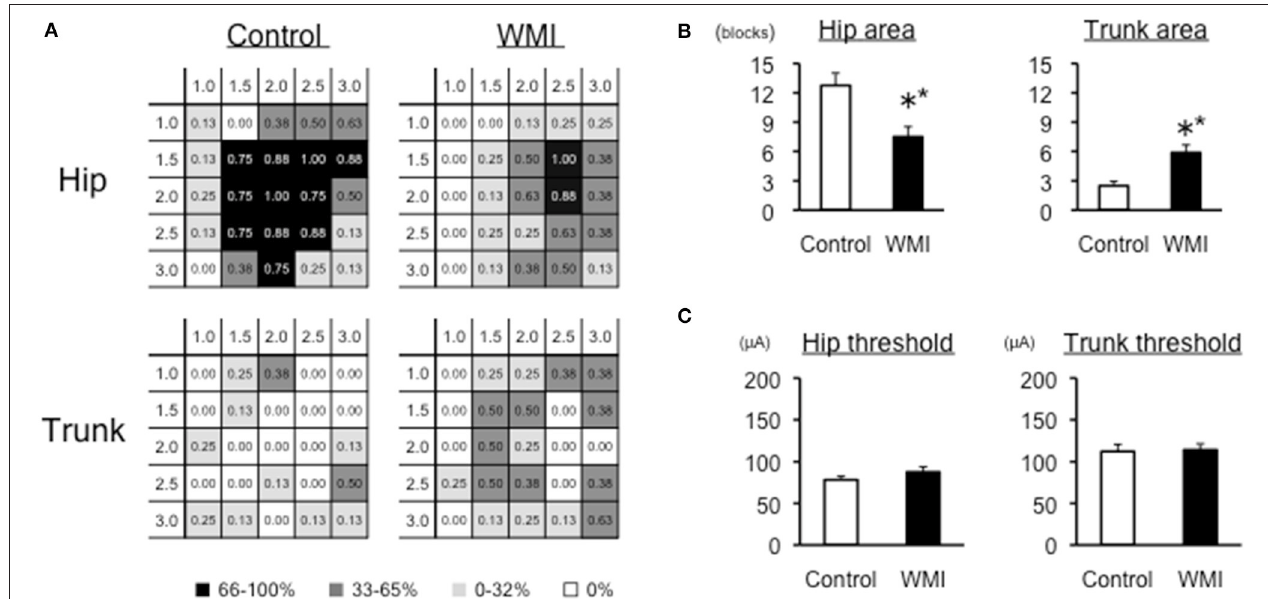
FIGURE 2 | Electrophysiological analysis of sensorimotor cortex by ICMS at 10 weeks of age . (A) A summary of the motor maps in Figure 1 is shown as a heat map that represents the occurrence rate of each stimulated spot: the number of animals in which the movement was elicited was taken over the number of times that spot was stimulated in each group ( n = 8 for each group). Each number in the grid shows the rate of responsive individuals in each portion, displayed as monochrome heat maps. Note that the rate for the hip area decreased in the WMI model, whereas the rate for the trunk area increased. (B) The number of grids associated with the hip area was significantly reduced, while that of the trunk area significantly increased in neonatal WMI model animals. (C) The minimal current intensity (threshold) to evoke muscle twitch was unaltered between the groups with regard to both the hip and trunk area. ** p < 0.01 by Mann–Whitney U -tests. Data are presented as mean ±